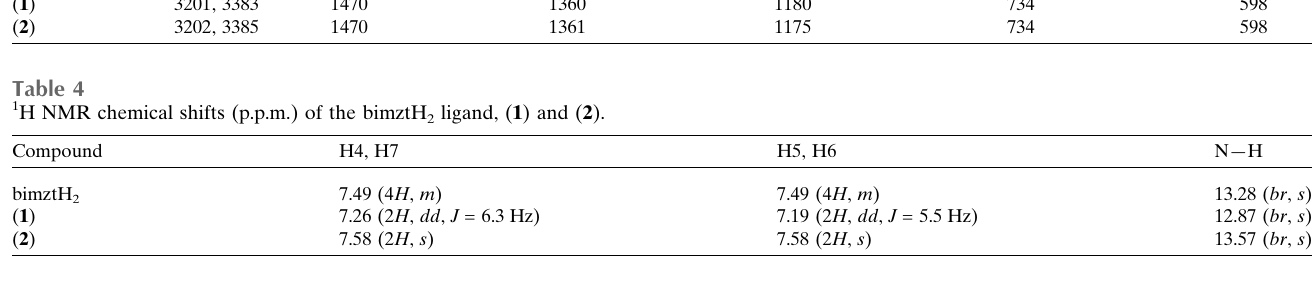
Table 5 13 C NMR chemical shifts (p.p.m.) of the bimztH2 ligand and ( 1 ) and ( 2 ). Compound